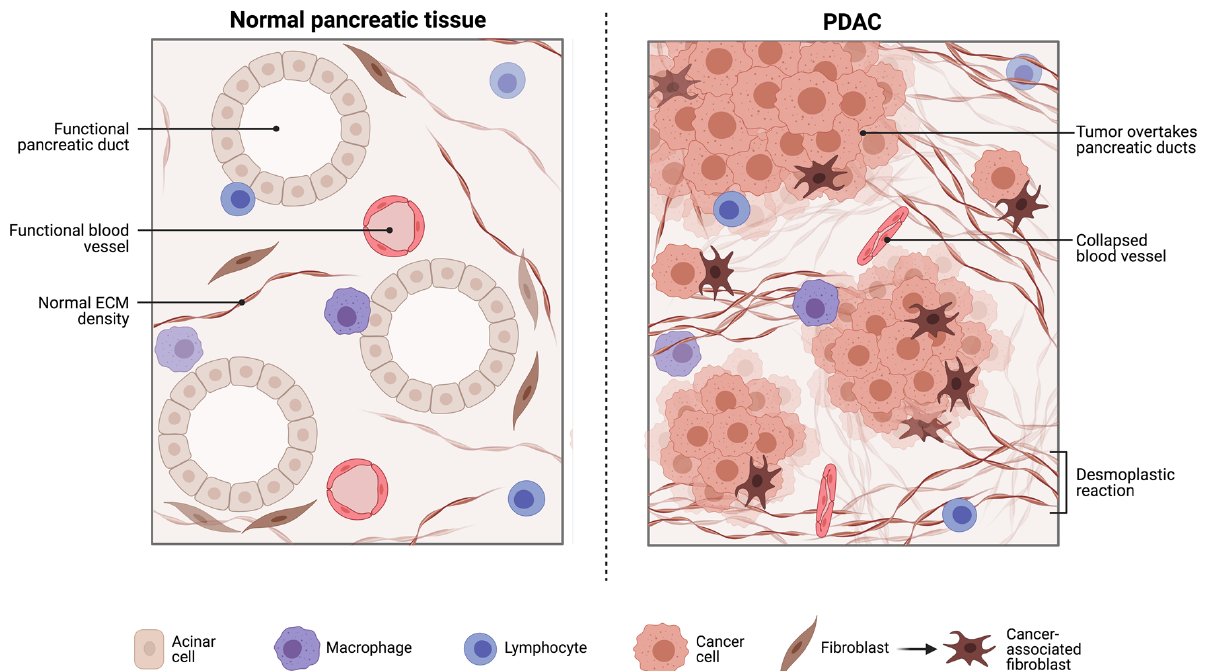
Figure 1. The PDAC TME is heterogenous and poorly characterised. The PDAC TME contains tumour associated macrophages (TAM), myeloid-derived suppressor cells (MDSCs) and regulatory T-cells (T-regs) that are all involved in immunosuppressive tumour promoting activity. Furthermore, there are dense desmoplastic reactions as well as collapsed vessels which all provide barriers to cytotoxic T cell infiltration targeting PDAC tumour cells. The TME affords PDAC protection against chemo- and